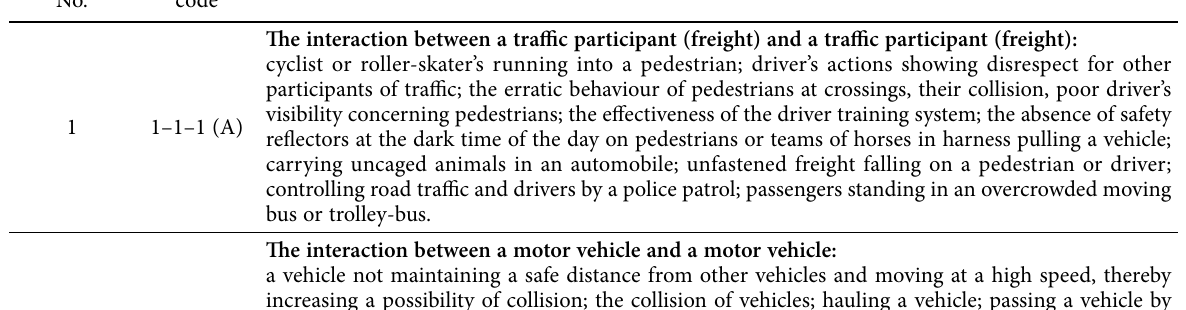
Table 1. A list of criteria describing the interaction between the elements at various levels of the TS having an impact on the accident rate on the road Interaction